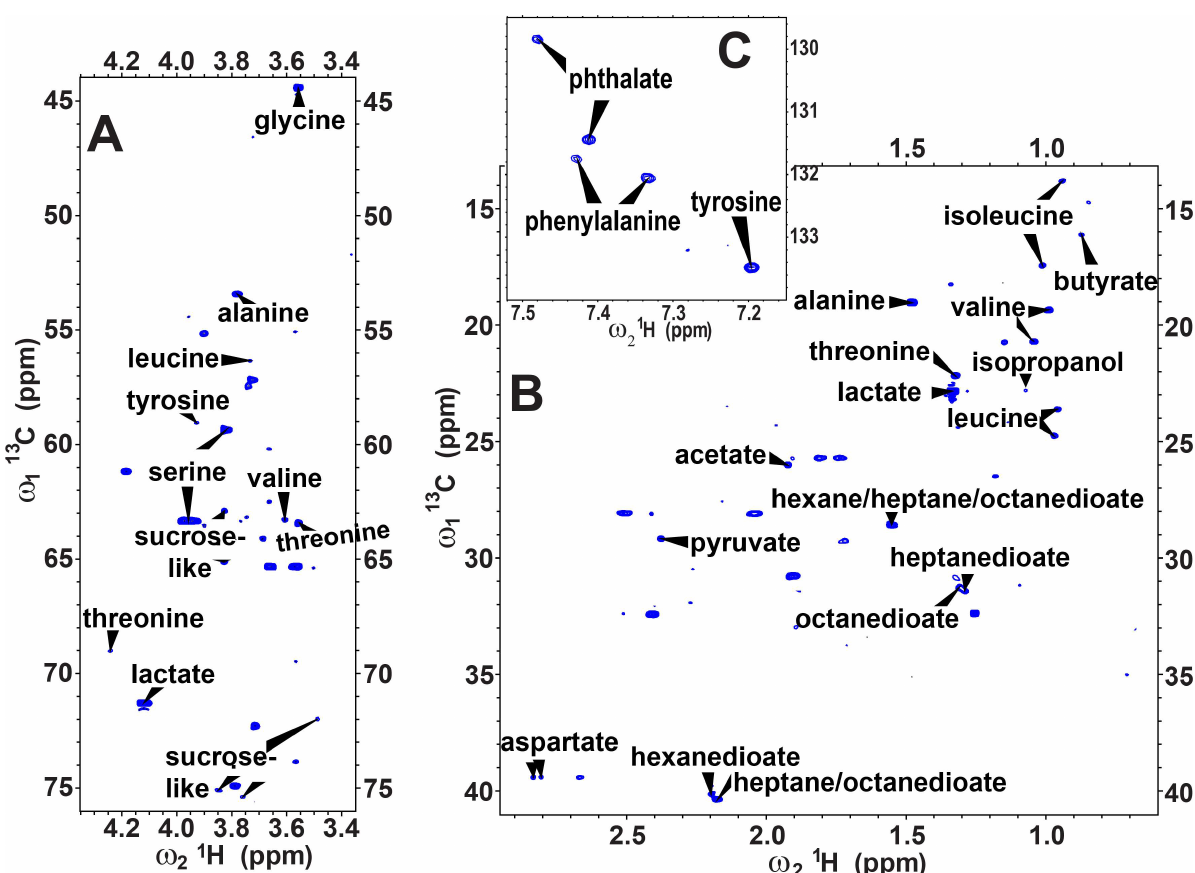
Fig 3. Multiple carboxylic acids are exhaled by cats. Regionsof a natural abundance 13 C HSQC NMR spectrum of a comparatively concentrated EBC specimen from a healthy cat are plotted with assignments for (A) the methine (-CH) region, (B) the methylene and methyl regions, and (C) the aromatic region. The sensitivity-enhanced HSQC was acquiredat 25˚C for 17.5 h at 800 MHz with a cryoprobe. Apodization with a squared sine bell introducedenoughline broadening in the 1 H dimensionto mask multiplet